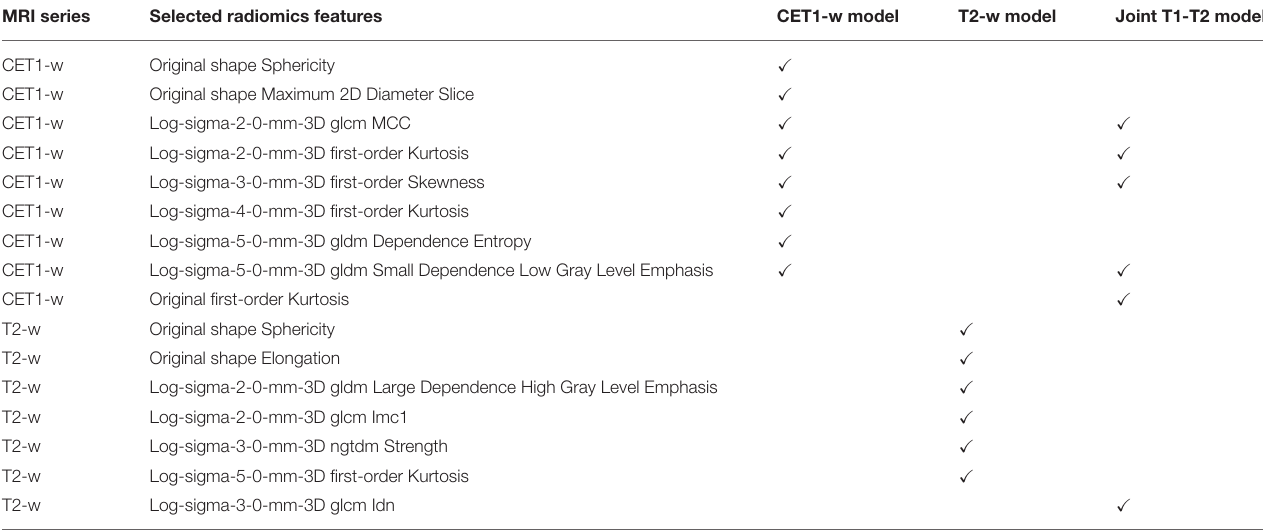
TABLE 2 | Table of selected features in CET1-w, T2-w, and joint T1-T2 radiomics models. MRI